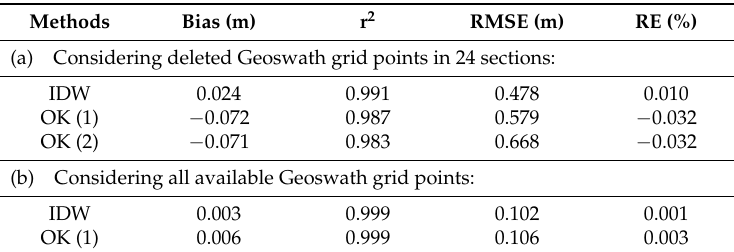
Table 4. Summary of the statistical analysis for the spatial interpolation